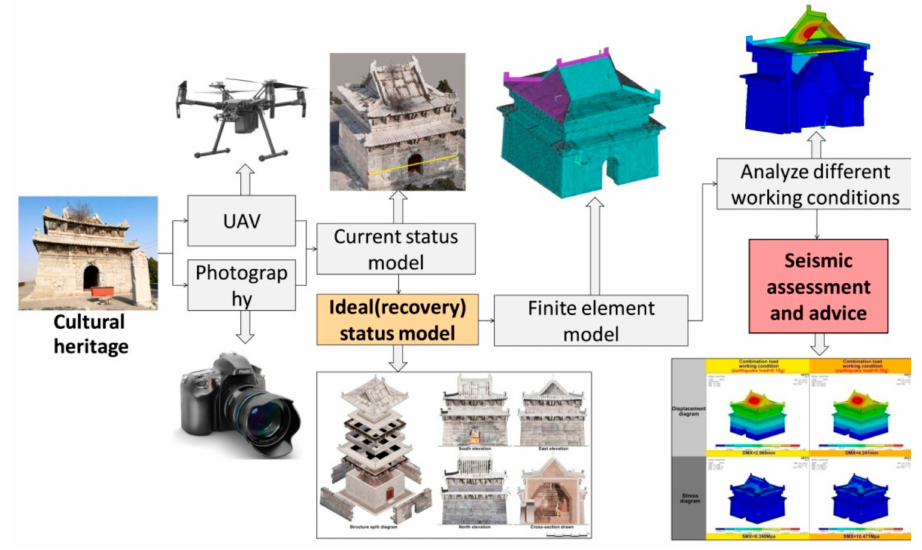
Figure 5. Digitization and earthquake resistance analysis flow diagram of architectural heritage with multilayer